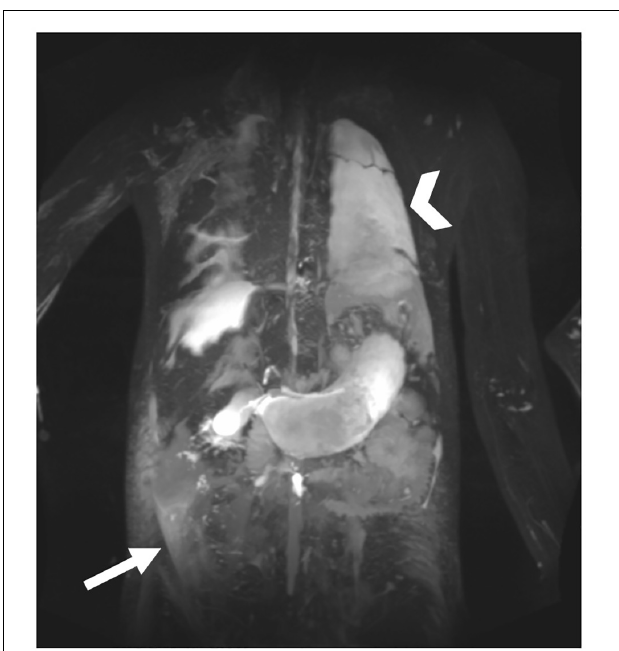
FIGURE 10 | MIP coronal projection of T2 imaging in patient with multicompartment lymphatic failure including ascites (arrow), PLE, edema, and chylothorax (arrowhead).